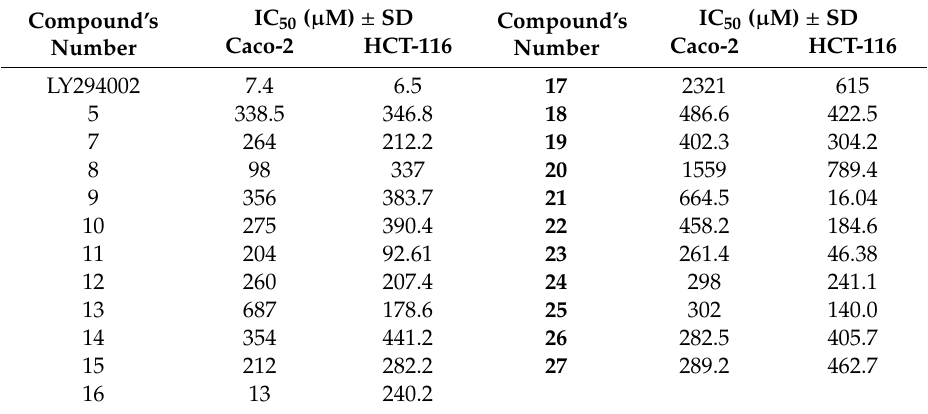
Table 2. The inhibitory activity (IC 50 µ M) of 5 , 7 – 27 . SD does not exceed